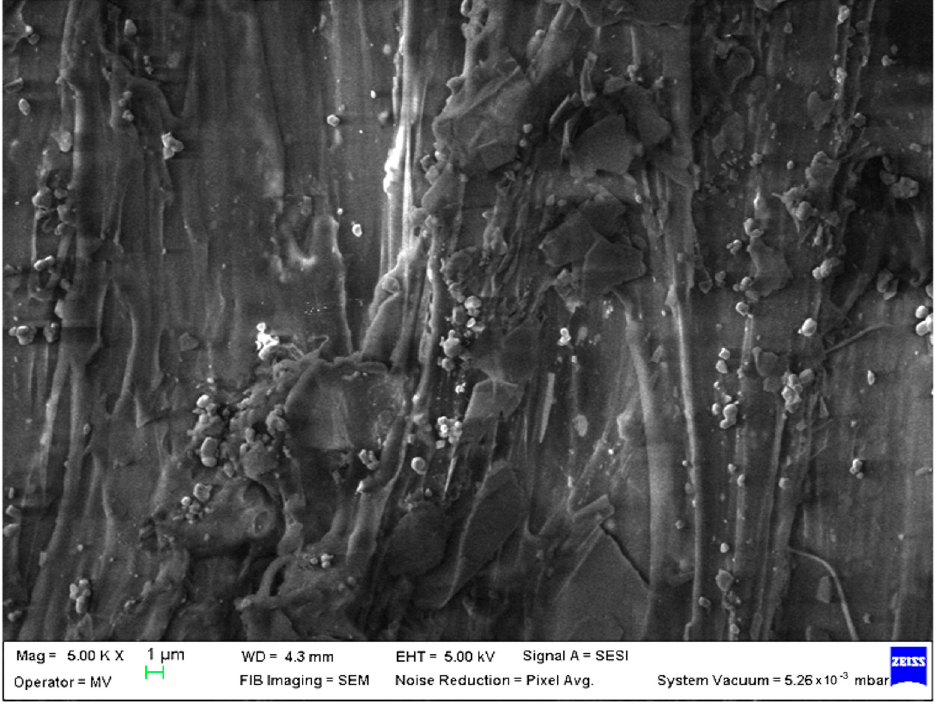
Figure 3. SEM micrographs of PET–Al composites (M3) sample at T 0 (1 µ m scale).